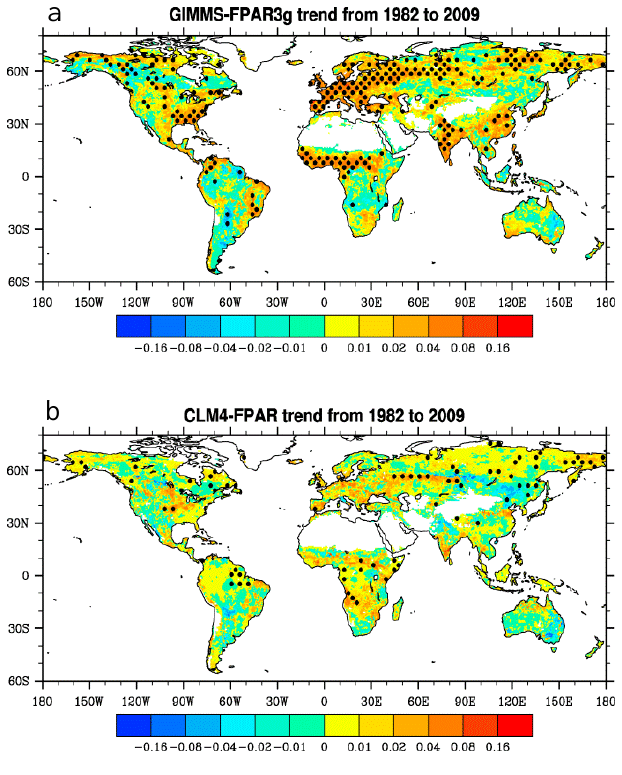
Figure 6. Global distribution of linear regression slopes in ( a ) GIMMS FPAR3g and ( b ) CLM4 FPAR from 1982 to 2009. Grids with slopes exceeding the 90% confidence level are marked with black